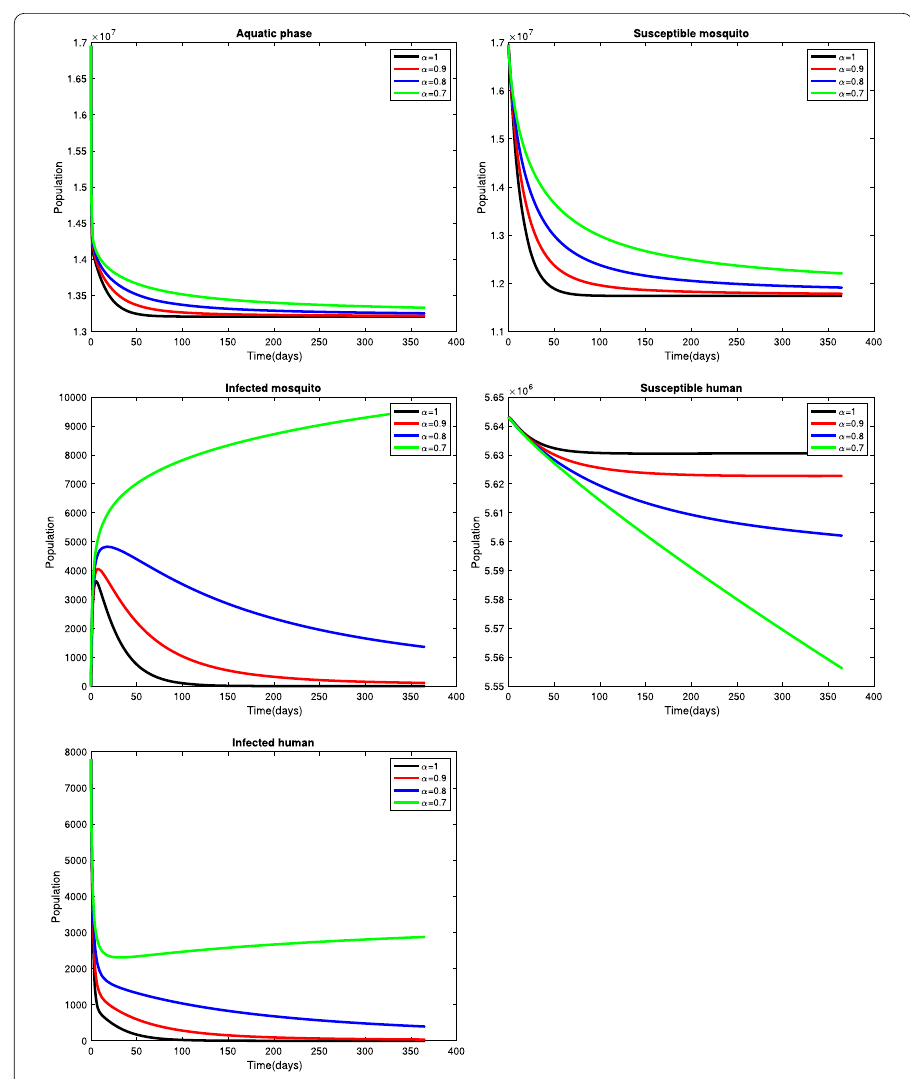
Figure 3 Numerical solution of model (4) with the parameter values q = 0.5, φ = 5.6, b = 0.3, β m = 0.35, β h = 0.375, μ A = 0.47, μ m = 0.09, μ h = 3.65 × 10 – 5, ρ h = 0.001, C = N h , σ A = 0.08, γ h = 0.5. R 0 <